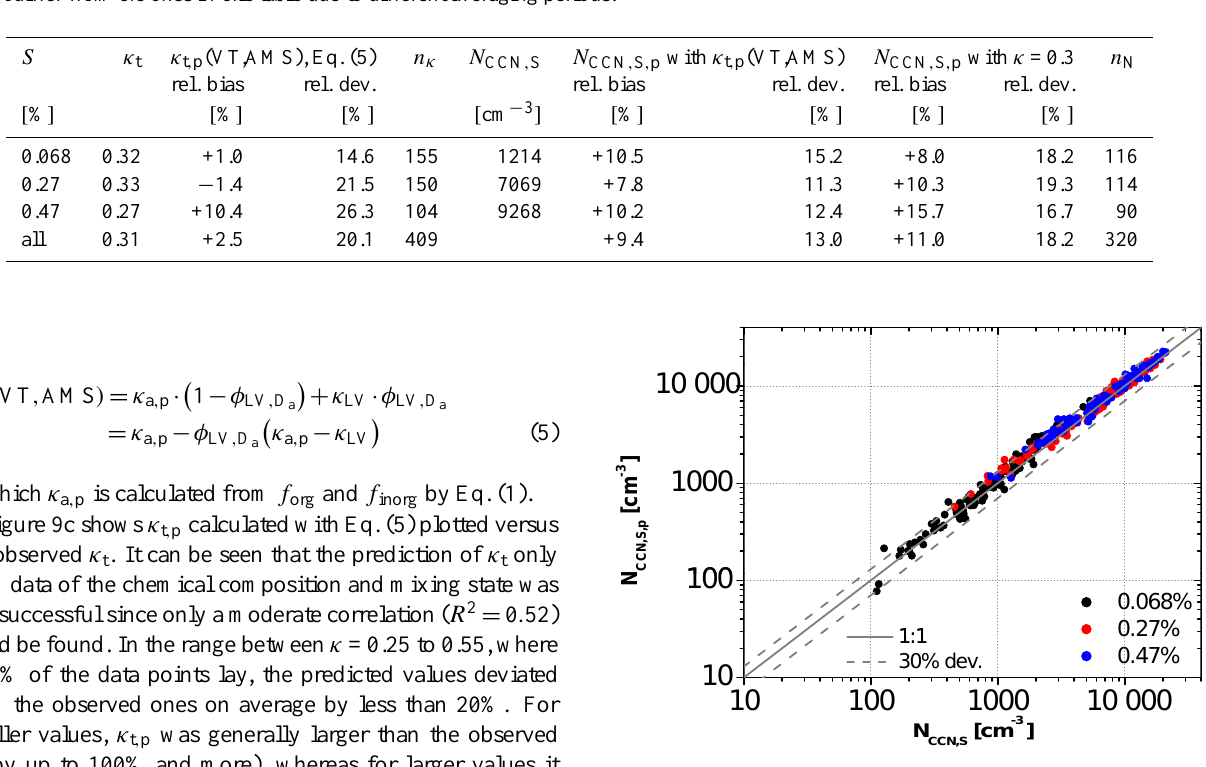
Table 4. Arithmetic means of the observed κ t and N CCN , S values, and characteristic deviations between predicted values ( κ t , p and N CCN , S , p ) and those observed (relative bias and total relative deviation, including systematic and statistical errors) for the entire campaign. n κ and n N are the number of data points that are contained in the averages of κ t , p and N CCN , S , p , respectively. Note that comparable values from Table 3 might differ from the ones in this table due to different averaging periods.